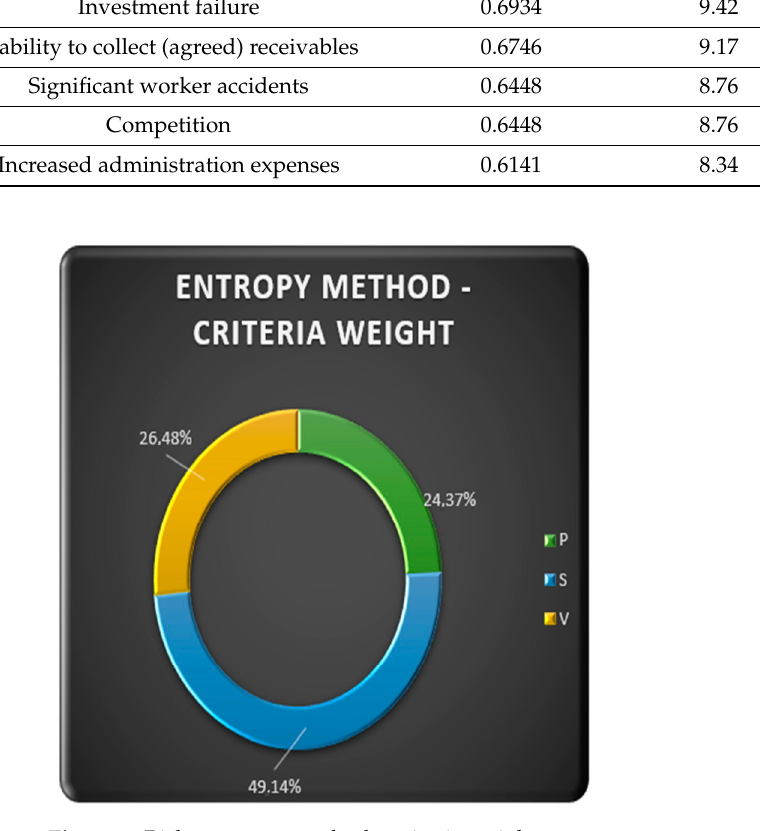
Figure 7. Risk—entropy method—criteria weights.